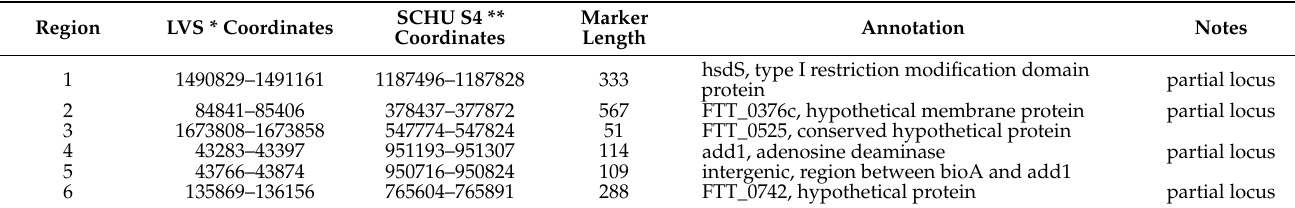
Table 3. Detailed information regarding the six genomic regions unique to F. tularensis based upon in silico analyses.